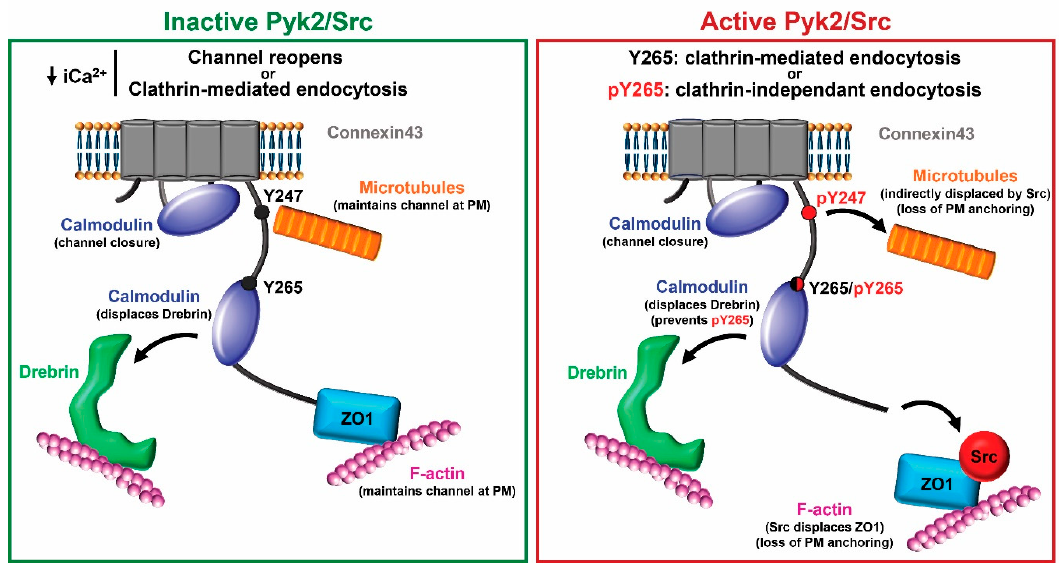
Figure 10. Proposed model for the role of CaM binding Cx43 with and without active Pyk2/Src. Left (inactive Pyk2/Src): Binding of CaM to the CL aids in closure of the channels by a structural change in the CL and/or steric hindrance of the pore. CaM also binds to the CT and displaces Drebrin, which interacts with F-actin. Once the level of intracellular Ca 2+ decreases, the channels could reopen because Cx43 maintains its interaction with the microtubule and actin network (via ZO-1) or exposure of the AP-2 binding site Y 265 XX Φ upon CaM release would promote clathrin-mediated endocytosis. Right (active Pyk2/Src): Pky2/Src phosphorylation of Y247 displaces the microtubule and the direct interaction between Src and ZO-1 displaces ZO-1 as well as F-actin from Cx43. These channels are marked for internalization. However, the mode of internalization, clathrin- mediated or clathrin-independent, depends on the level of protection from phosphorylation at residue Y265 provided by CaM. Of note, this is a simplistic model that does not illustrate the many other protein partners that are involved in the regulation of Cx43. PM: plasma membrane.